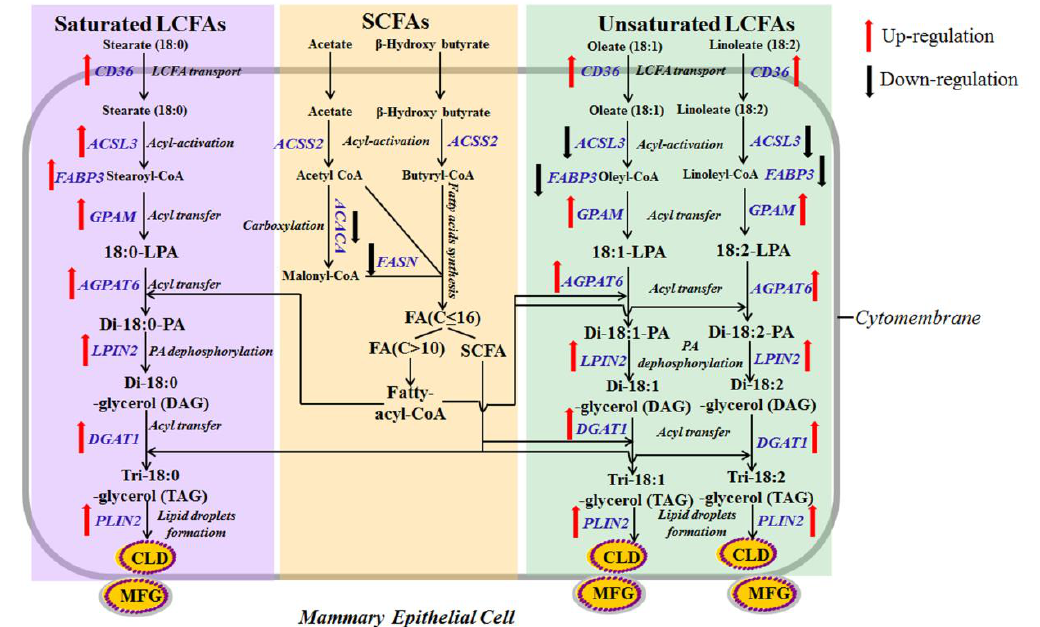
Figure 6. Scheme summarizing interrelationships among cellular pathways regulating lipid synthesis by stearate, oleate and linoleate in pMECs. The 18-carbon fatty acids (stearate, oleate and linoleate) (C18:X) enhanced the uptake of exogenous LCFA, TAG synthesis and lipid droplet formation. Uptake of LCFA in pMECs was enhanced by 18-carbon fatty acids (C18:X) through activating transport proteins (mainly CD36). Cytosolic C18:X is converted into its activated form (18:X-CoA) with the help of ACSL. Cytosolic 18:X-CoA is transported to the endoplasmic reticulum membrane by FABP and esterified there to glycerol-3-phosphate to produce 18:X-lysophosphatidic acid (18:X-LPA) by GPAM. Interestingly, the mRNA expressions of ACSL3 and FABP3 were different with 18-carbon fatty acids. Cellular ACSL3 and FABP3 mRNA expressions were increased by stearate but decreased by oleate or linoleate. In the endoplasmic reticulum, the addition of a second 18:X-CoA produces di-18:X-phosphatidic acid (di-18:X-PA), and di-18:X-PA can be hydrolyzed with LPIN to form a di-18:X-glycerol (DAG). The sn-3 position of DAG is then acylated to form TAG by DGAT. Newly formed TAG forms a cytoplasmic lipid droplet in the ER membrane via incorporation. Then, the cytoplasmic lipid droplet is transported to the apical membrane, and eventually released. The 18-carbon fatty acids suppressed the fatty acid de novo synthesis. In mammary cell, short- and medium-chain fatty acids (almost all C4:0–C14:0 and approximately 50% of palmitic acid) were highly dependent on the de novo synthesis. A series of cytosolic enzymes are required to facilitate this process, of which FASN and ACACA are considered the crucial enzymes of cellular fatty acid de novo synthesis in the porcine mammary gland. ACACA carboxylates acetyl-CoA to form malonyl-CoA, which is further converted by FASN to fatty acids (C ≤ 16). Then, the synthesized fatty acids participate in TAG formation in endoplasmic reticulum.